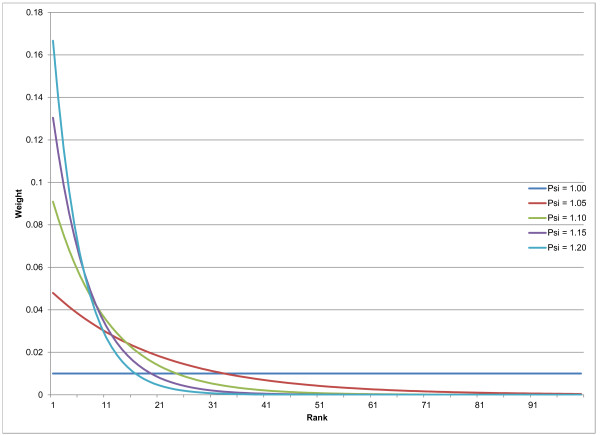
Example weighting schemes for 100 component models at different values of ψ.